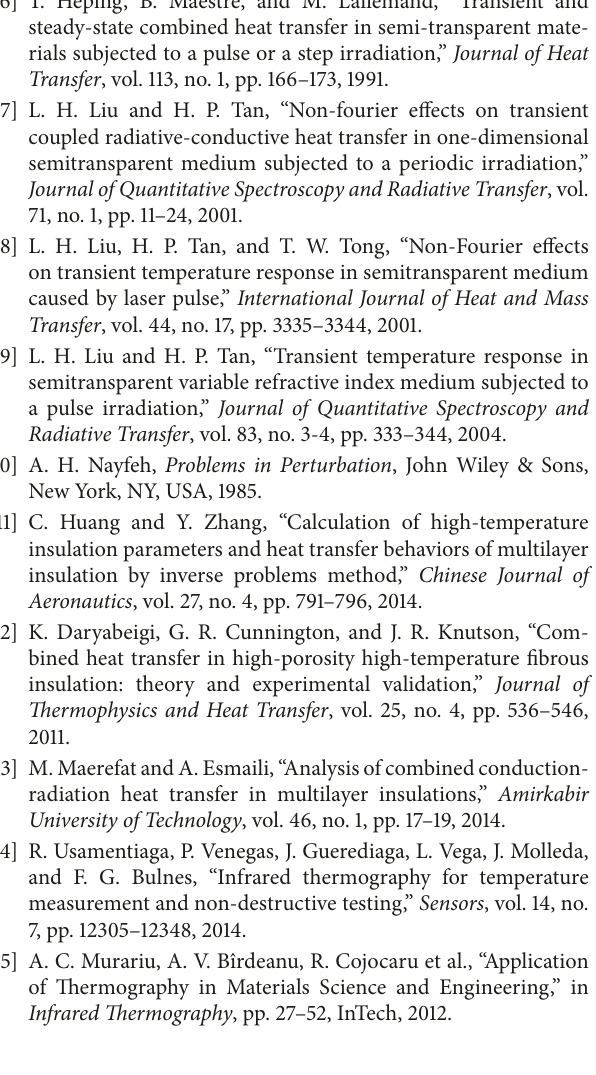
Figure 5: Directional dependence of 𝐽 out V for different value of boundary’s S 1 emissivity 𝜀 1